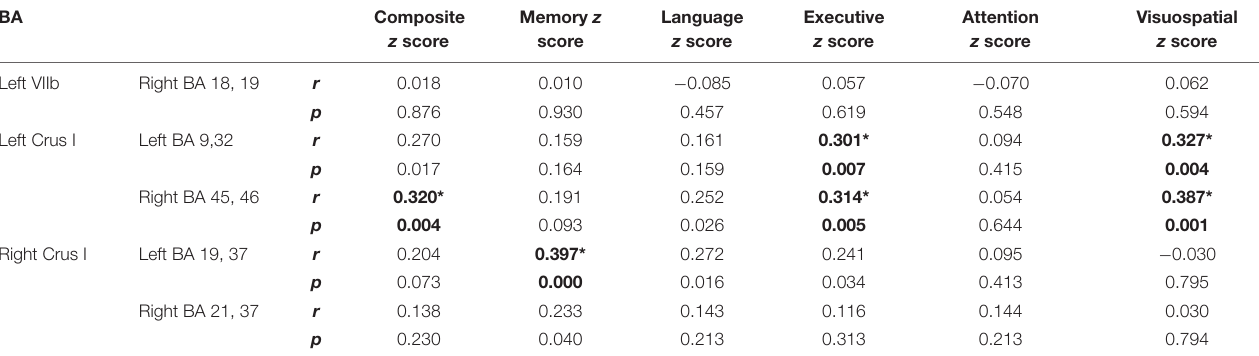
TABLE 3 | Spearman Correlation between cognition and cerebellar